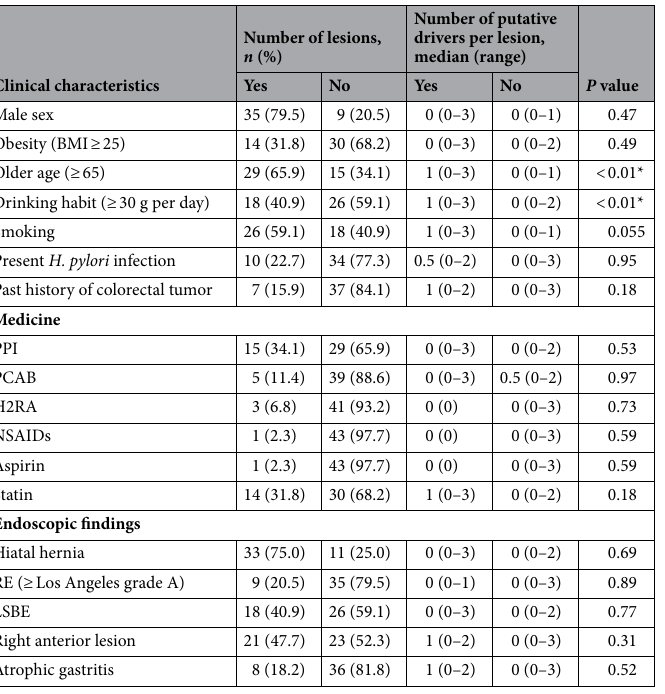
Table 5. Association between patients’ demographics and the number of putative drivers. BMI body mass index, GERD gastroesophageal reflux disease, H2RA H2 receptor antagonist, LSBE long-segment